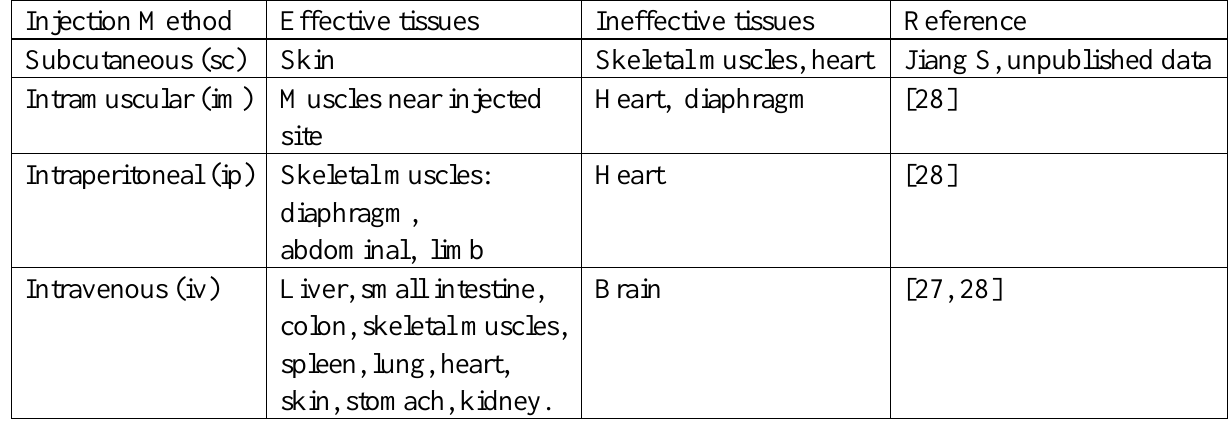
Table 2. Tissues that were tested for antisense effect in mice injected with Vivo- Morpholinos by different